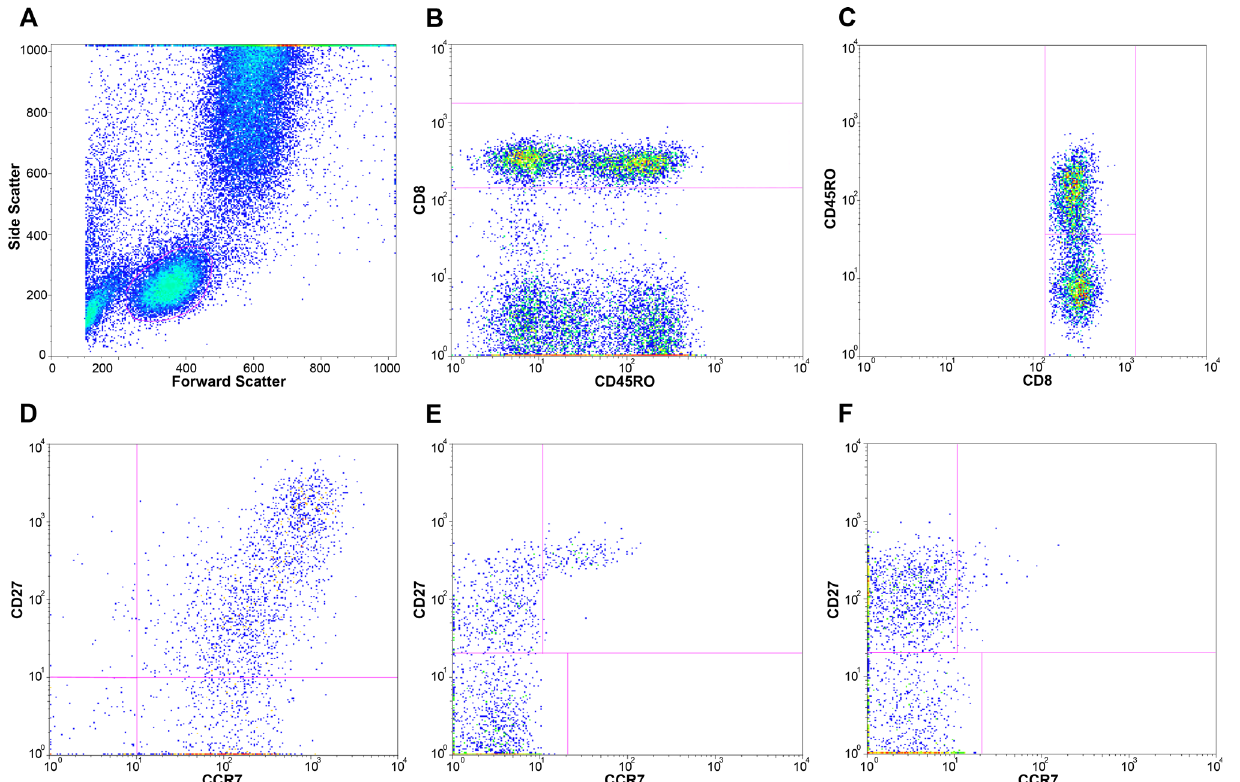
Fig 1. Gating strategy for CD8+ lymphocytes. These plots represent the gating strategy used for flowcytometry analysis of blood samples; A, lymphocytes were gated on a forward scatter area versus side scatter area dotplot; B, CD8+ bright lymphocytes were gated for further determination of subpopulations; C, CD45RO- and CD45RO+ events were gated to determine na ï ve and memory subpopulations of CD8+ bright lymphocytes; D, activation of memory CD8+ T cells was determined by determining the percentage of CD38 and HLA-DR double positive CD8+ memory lymphocytes. Maturational T cell subpopulations were identified by analysing the (co-)expression of CCR7 and CD27 within E, na ï ve and F, memory CD8+ bright